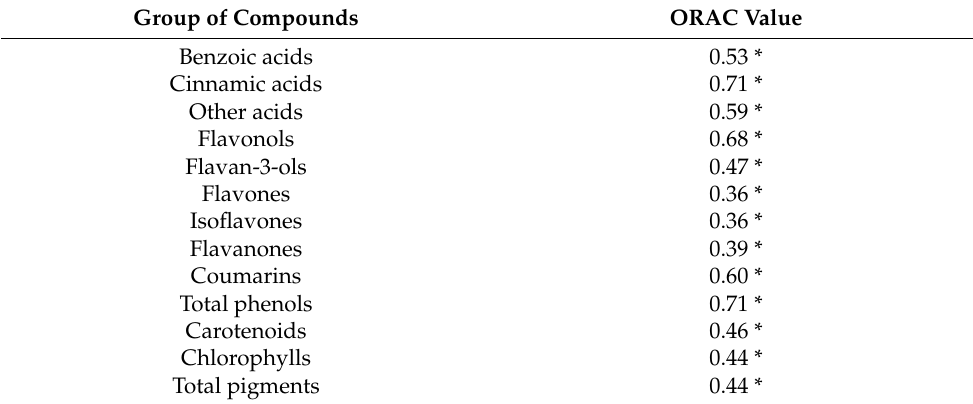
Table 5. Pearson’s correlations between analyzed compounds (mg 100 g − 1 dm) and ORAC values (mmol TE 100 g − 1 dm). Group of Compounds ORAC Value Benzoic acids 0.53 * Cinnamic acids 0.71 * Other acids 0.59 * Flavonols 0.68 * Flavan-3-ols 0.47 * Flavones 0.36 * Isoflavones 0.36 * Flavanones 0.39 * Coumarins 0.60